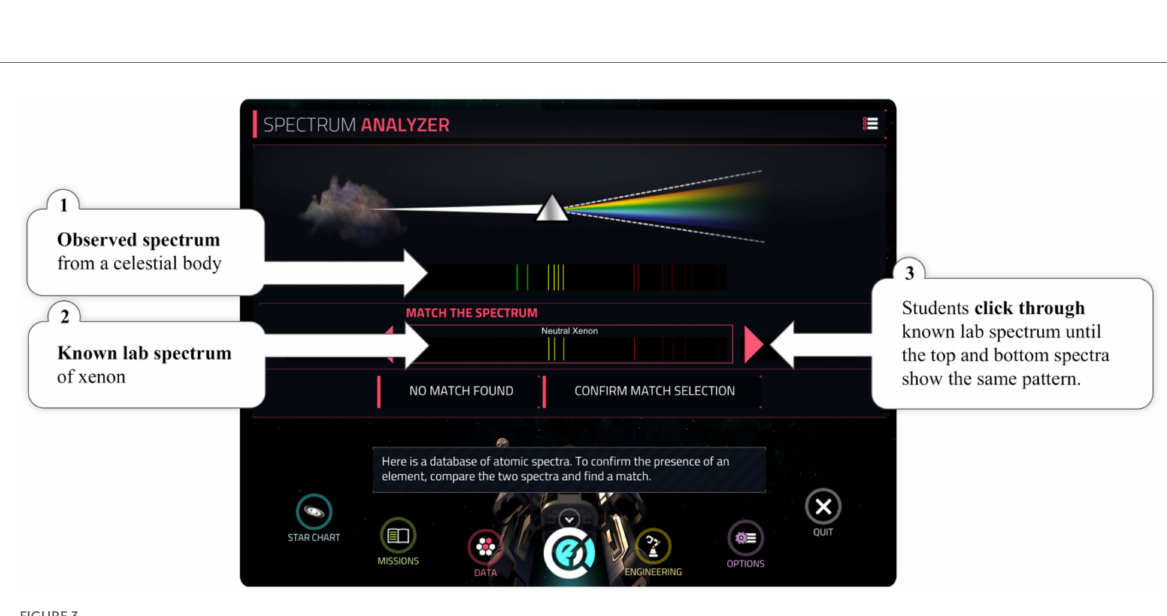
FIGURE 3 Example line emission spectra task: Students are asked to judge whether the observed spectrum (top) matches a lab spectrum (bottom). In this case, the student should see that the two spectra match. This task was presented in the Spectrum Analyzer Tool of the game, discussed below.